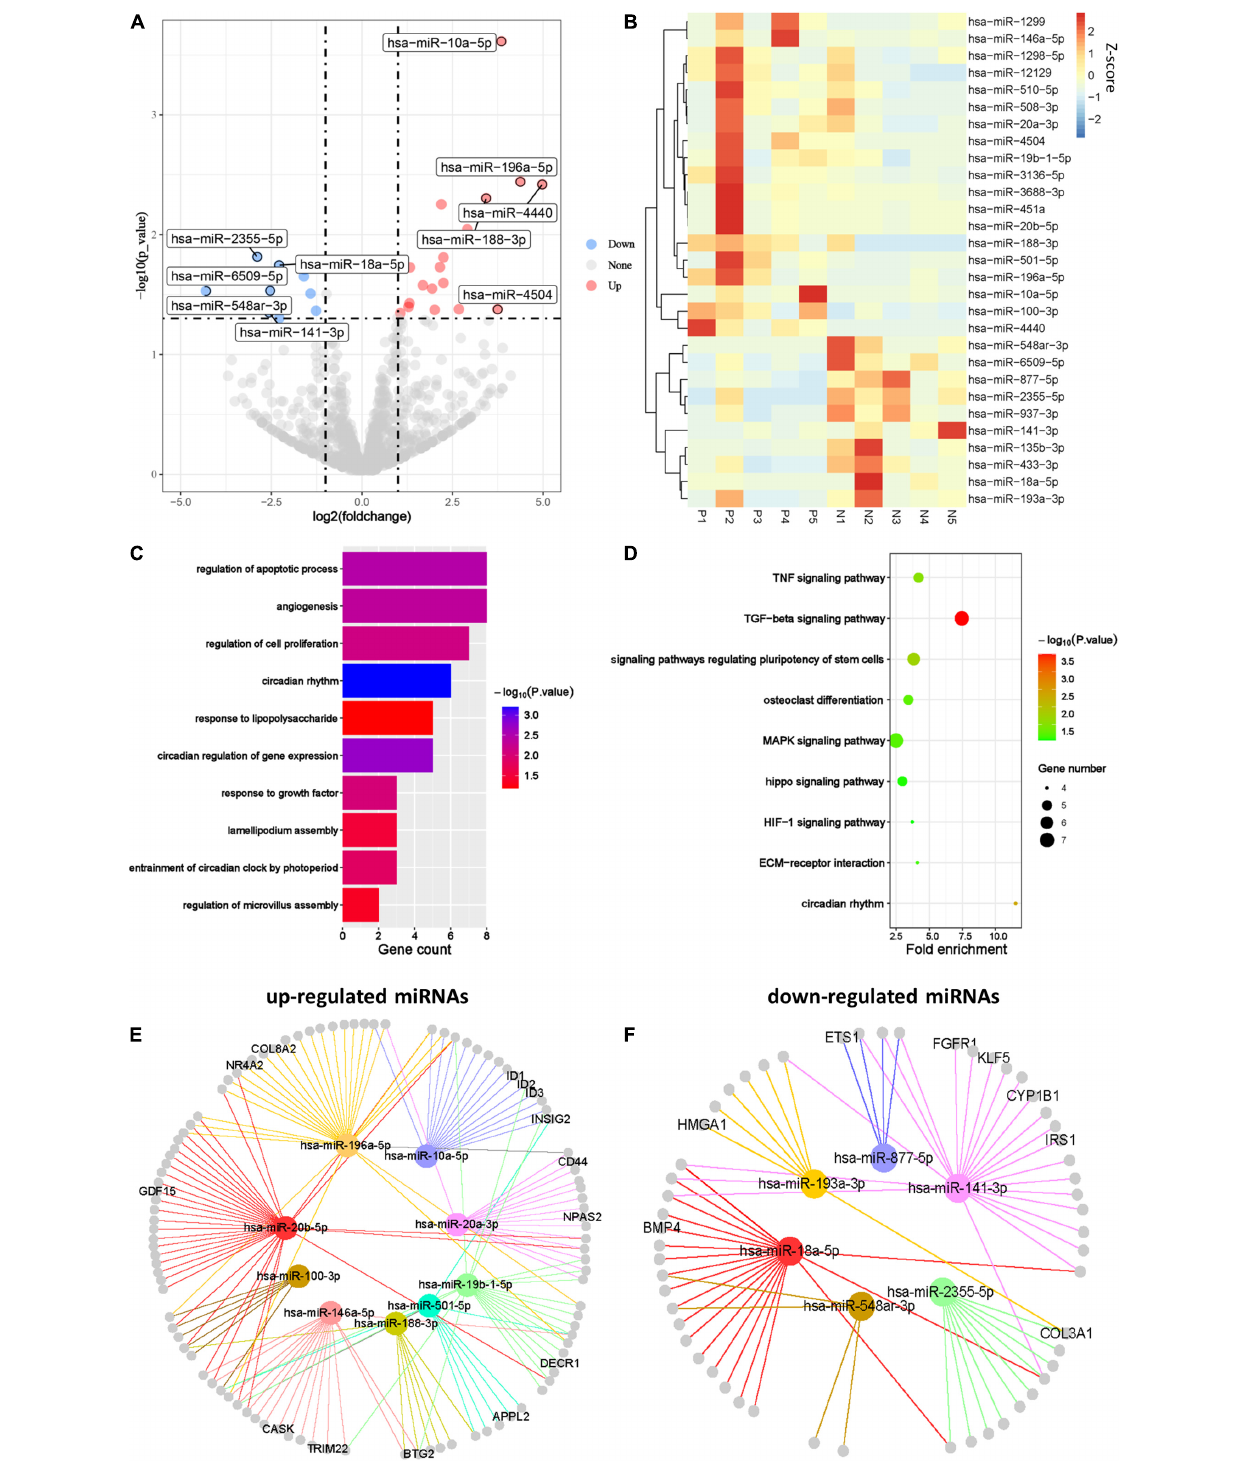
FIGURE 5 | The miRNA profiles of Human PCOS. (A) Volcano plot comparing miRNA expression profiles of PCOS and control GCs. Upregulated and downregulated miRNAs were colored in red and blue, respectively. (B) Heatmap of differentially expressed miRNAs between PCOS and control GCs. Each row represents a miRNA, and colors represent expression levels. (C,D) GO and KEGG analysis of differentially expressed miRNA target genes GCs obtained from PCOS and control ovaries. (E) Network diagram showing interaction between upregulated miRNAs and their target genes. (F) Network diagram showing interaction between downregulated miRNAs and their target genes. Colored nodes represent miRNA; gray nodes represent target genes; colored edges indicate miRNA-target interaction.